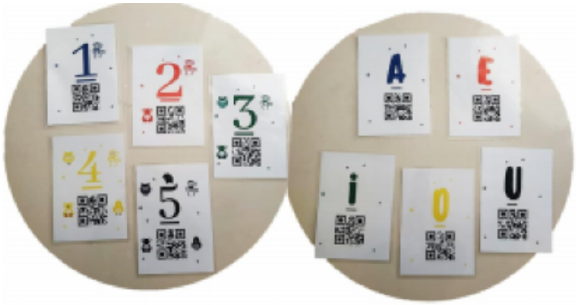
Figure 10. Cards approximately 14 cm long containing QR codes that children must show to the robot. The camera on the robot’s head detects if the card is correct based on the QR code.